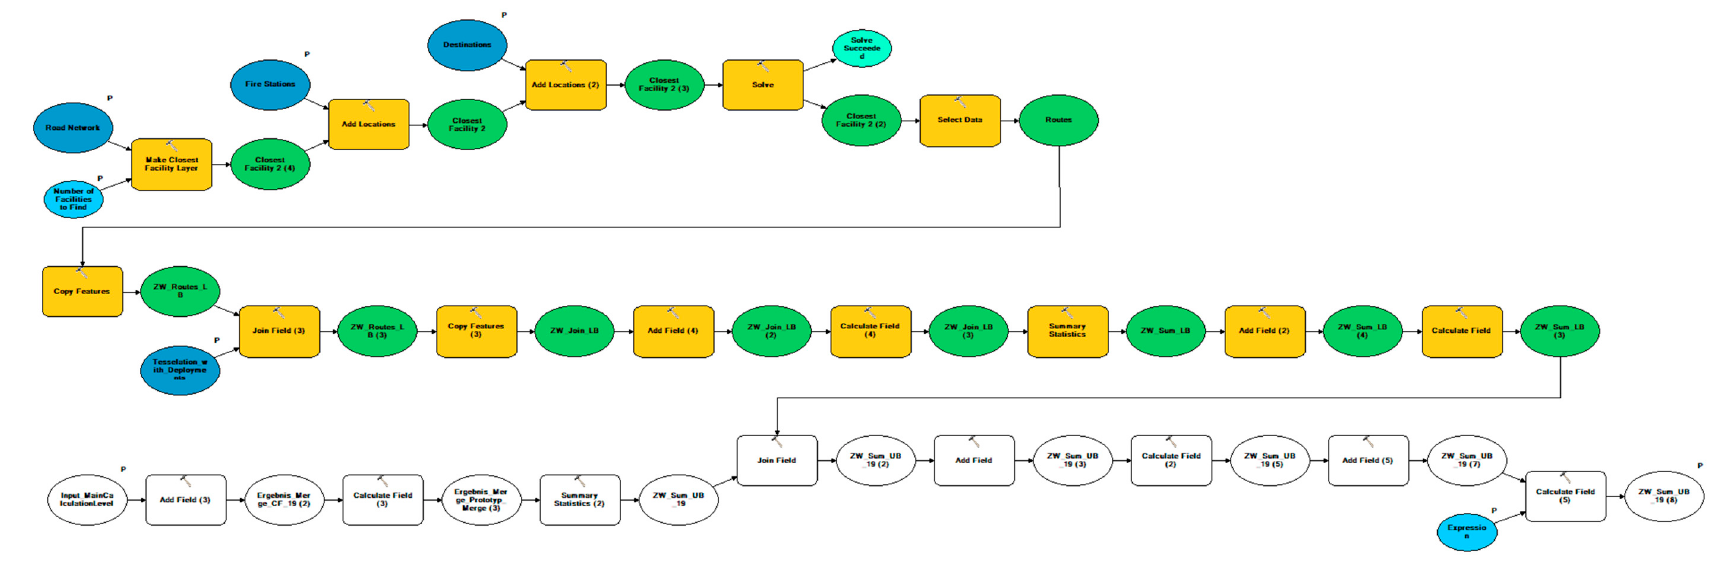
Figure A5. Routes without blockades calculation Level in ArcMap ModelBuilder.